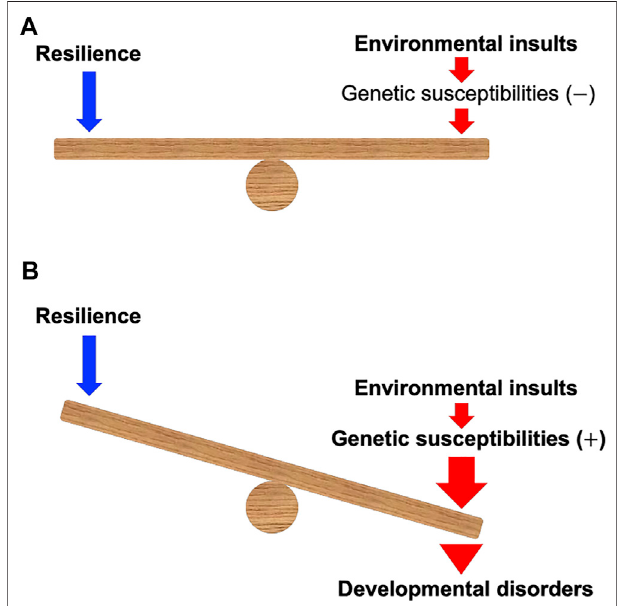
FIGURE 1 | A model of gene – environment interaction proposed in this mini-review. (A) When environmental insults during development can be counterbalanced by the resilience in the individuals without the genetic susceptibilities, the insults may not cause developmental disorders. (B) Environmental insults during development can be enhanced and defeat the resilience of the individuals with the genetic susceptibilities, which may cause developmental disorders. Note that genetic susceptibilities may modulate the power of resilience.